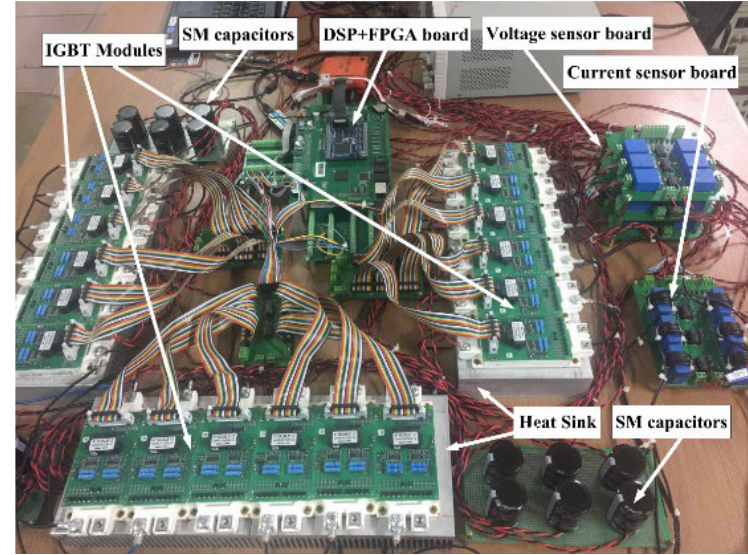
Figure 31 . Experimental photograph of the modified MMC. Figure 31. Experimental photograph of the modified MMC. Table 4. Circuit parameters for the experiment. Table 4. Circuit parameters for the experiment.